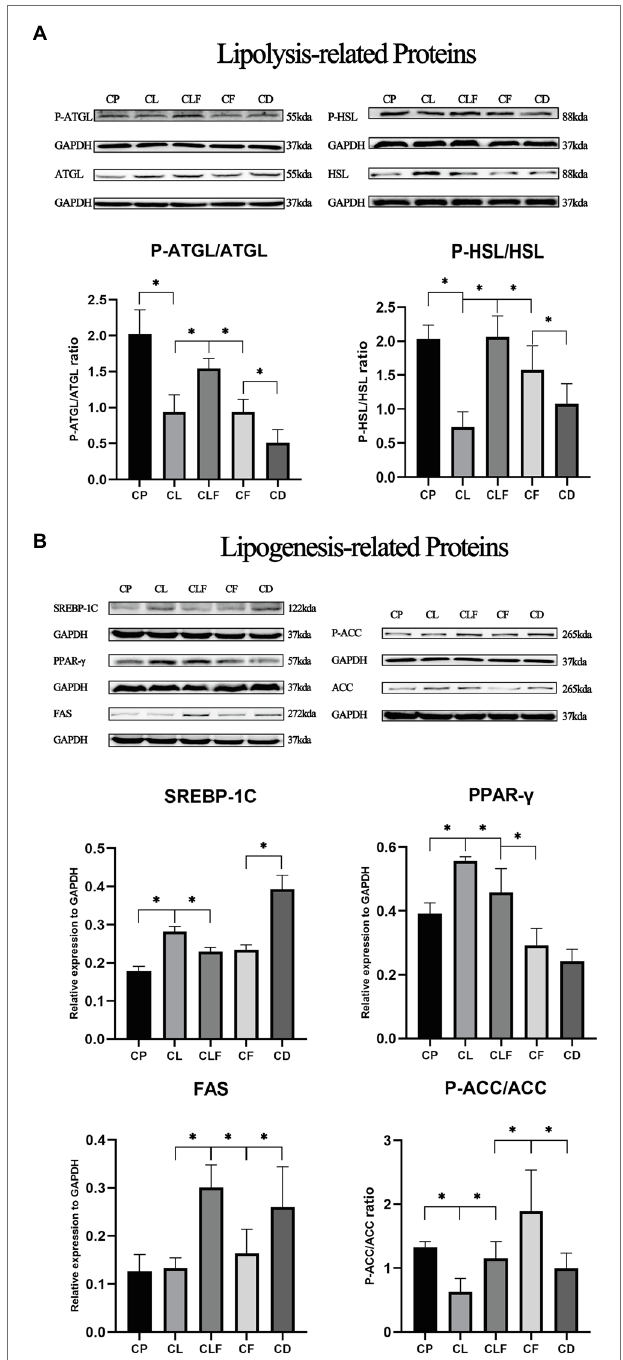
FIGURE 7 | The expression levels of lipid metabolism-related proteins after chronic lactate and forskolin injection. (A) Western blot analysis and relative fold protein expression of lipolysis-related proteins. (B) Western blot analysis and relative fold protein expression of lipogenesis-related proteins. CP, chronic PBS treated group; CL, chronic lactate treated group; CF , chronic forskolin treated group; CD, chronic DMSO treated group; and CLF, chronic lactate and forskolin treated group. Relative expression levels were normalized to GAPDH. Three bands are used for statistics. The data are presented as the mean ± SD, and significant differences among the groups were analyzed with one-way ANOVA. * p <